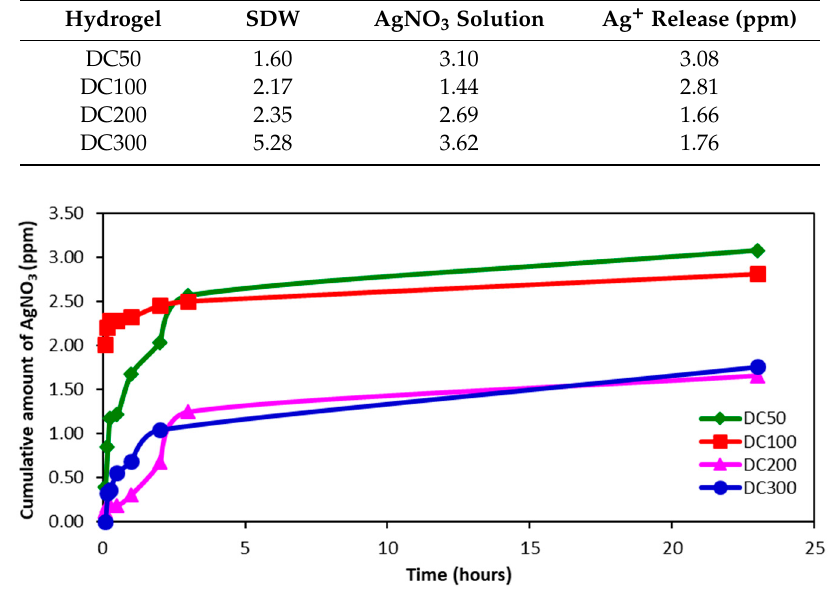
Figure 7. Cumulative release of Ag + (ppm) from the hydrogels. Table 3. Swell ratio ( w / w ) of hydrogels after 24 hours in sterile distilled water (SDW) or 0.0508% AgNO 3 solution.